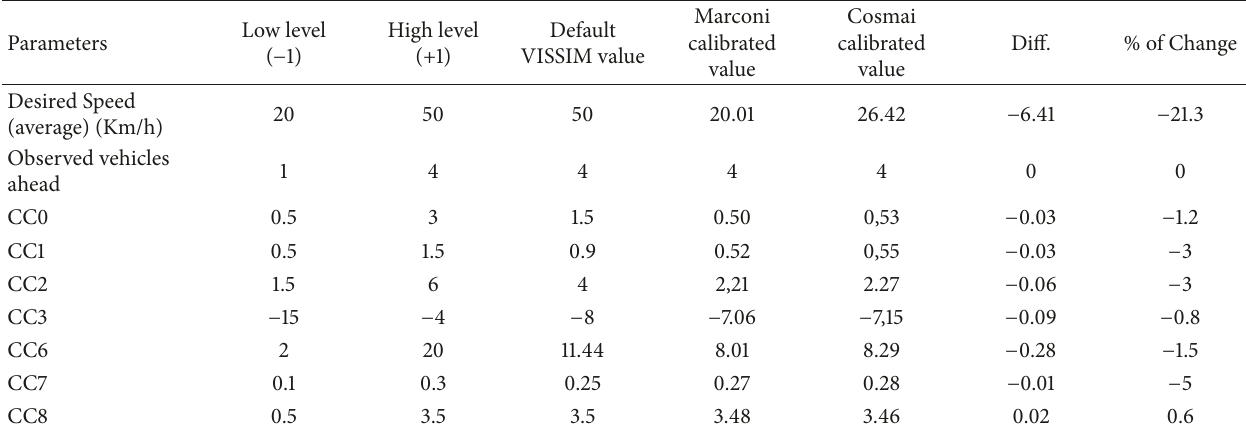
Table 12: Comparison of parameters calibrated for Marconi and Cosmai